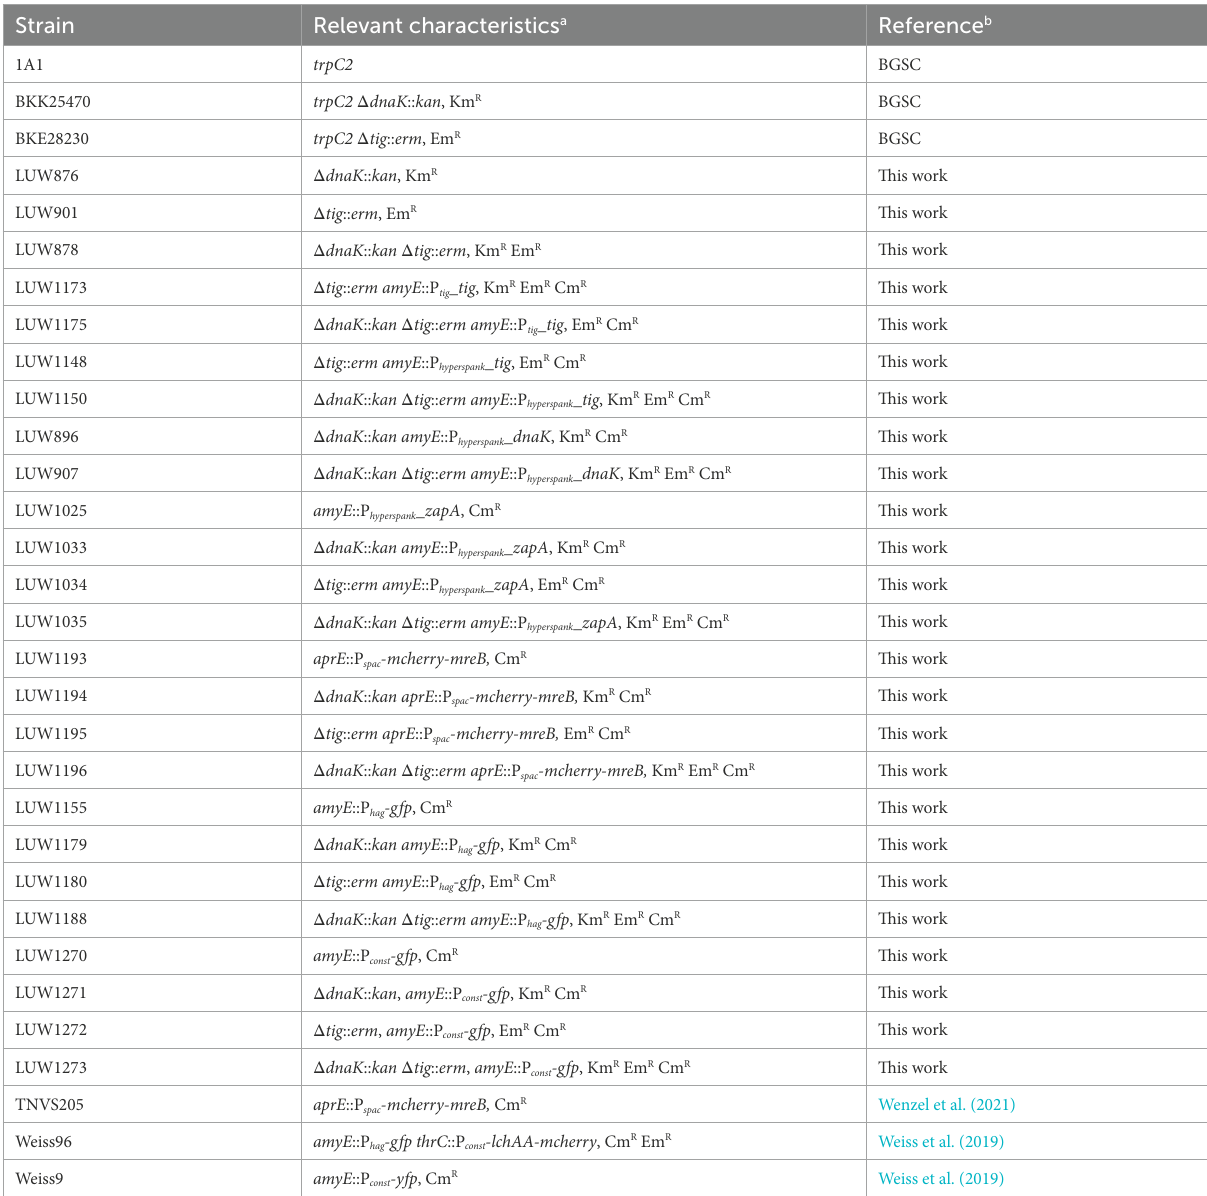
TABLE 1 Bacillus subtilis strains used in this study. Strain Relevant characteristics a Reference